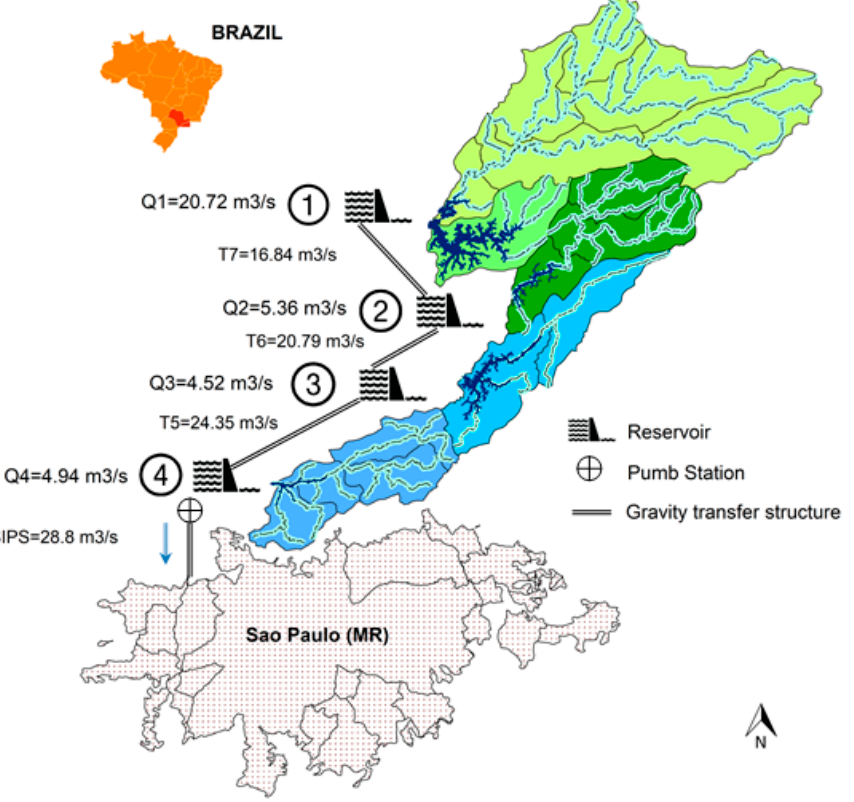
Figure 1. Cantareira water supply system: 1: Jaguarí–Jacareí subsystem; 2: Cachoeira subsystem; 3: Atibainha subsystem; and 4: Paiva Castro subsystem. Q x , daily average discharge of subsystem x,